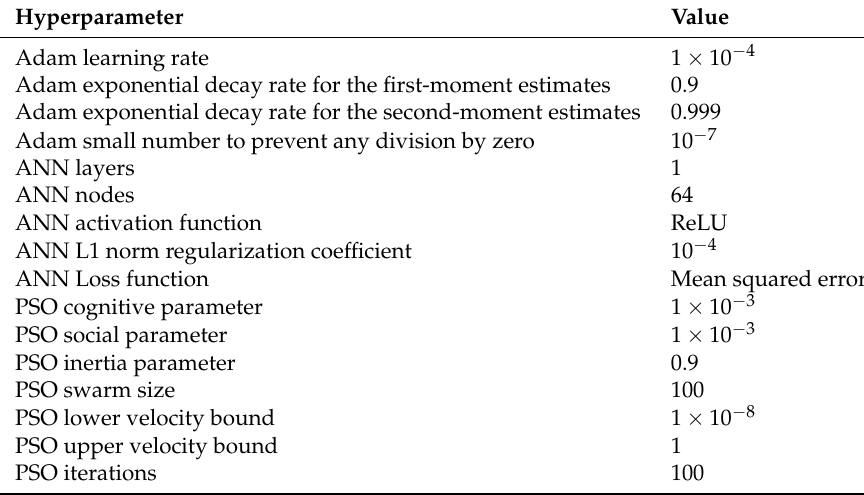
Table A1. ANN-PSO